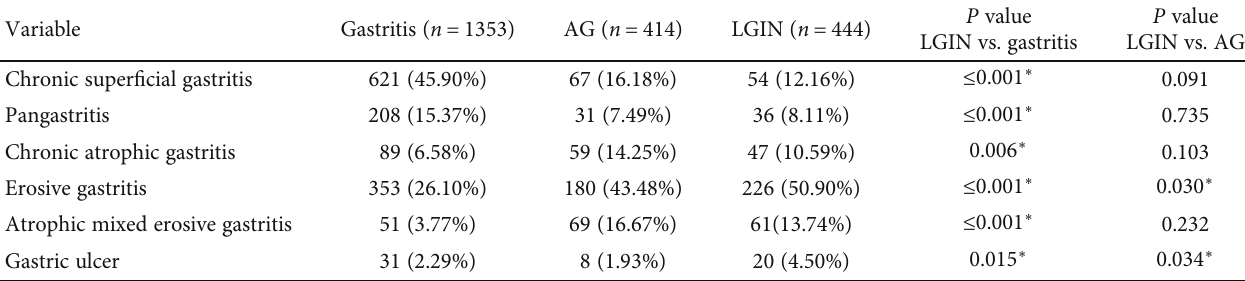
Table 4: Endoscopic classi fi cations of gastritis, AG, and LGIN.